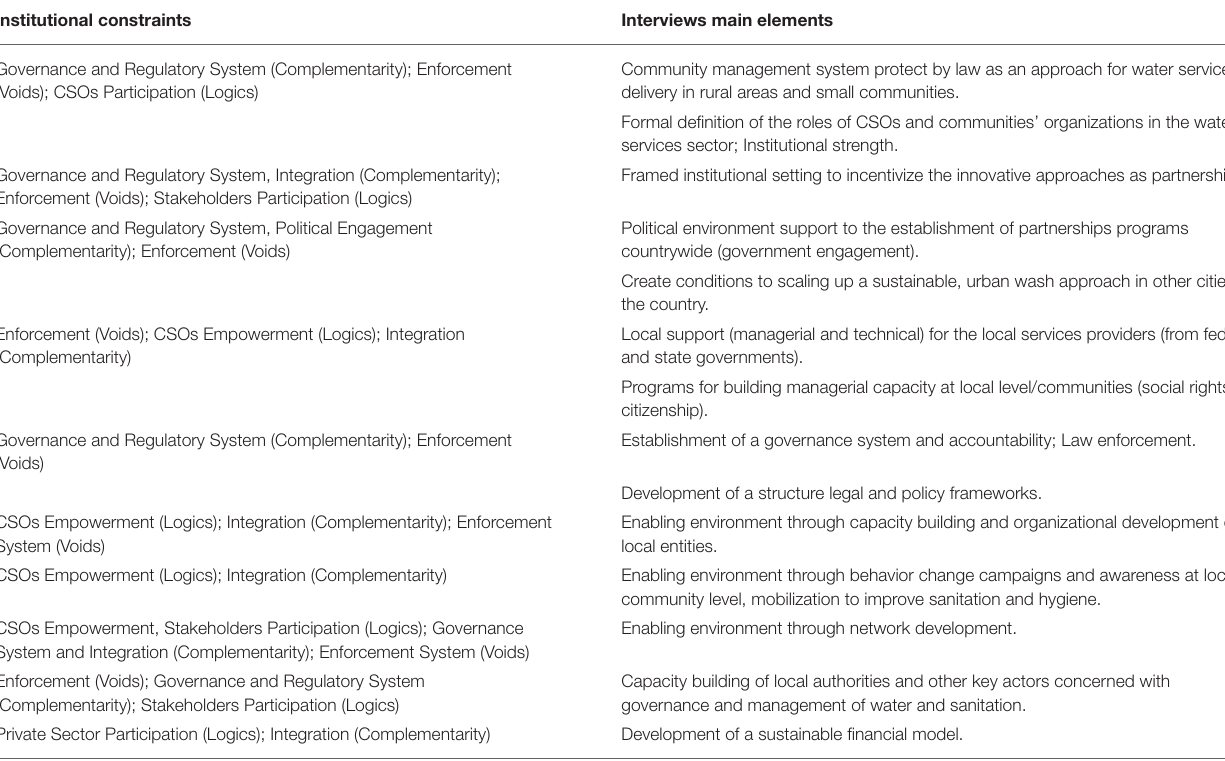
TABLE 2 | Dutch partnerships programs strengths: main elements from interviewees